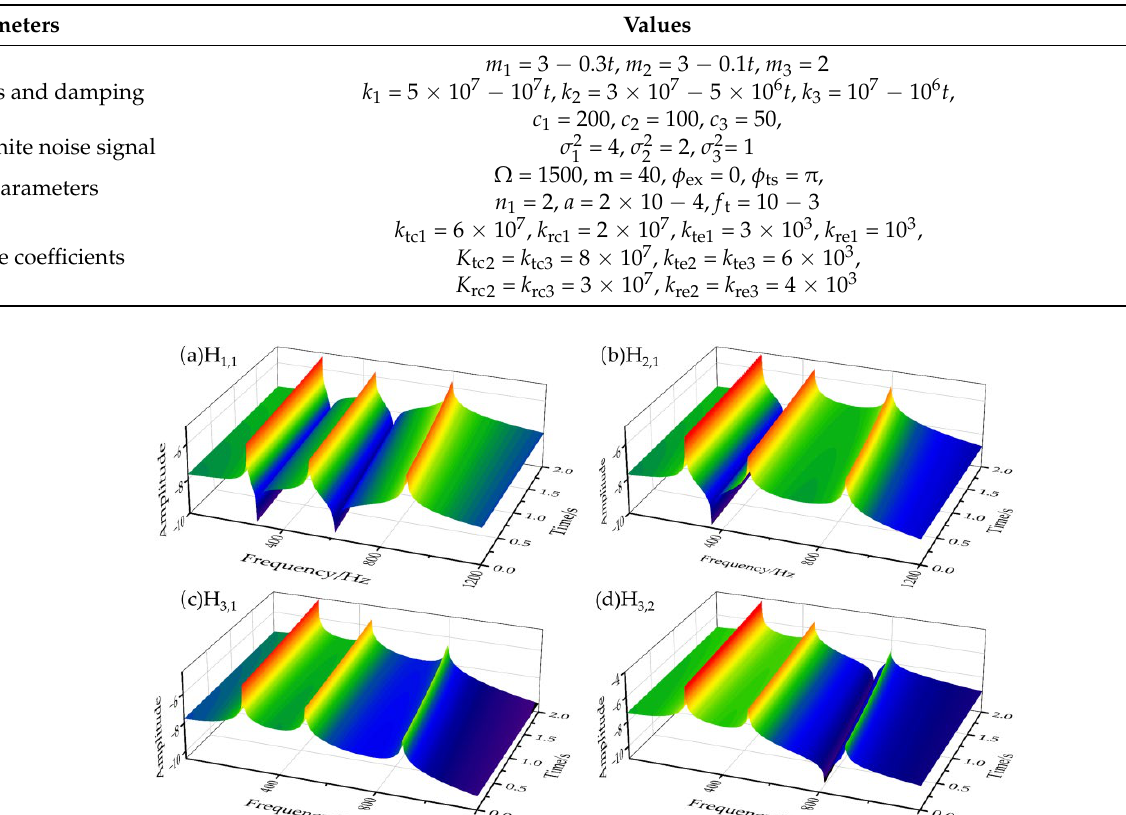
Table 1. Simulation parameters for the 3-DOF time-varying structure [39].